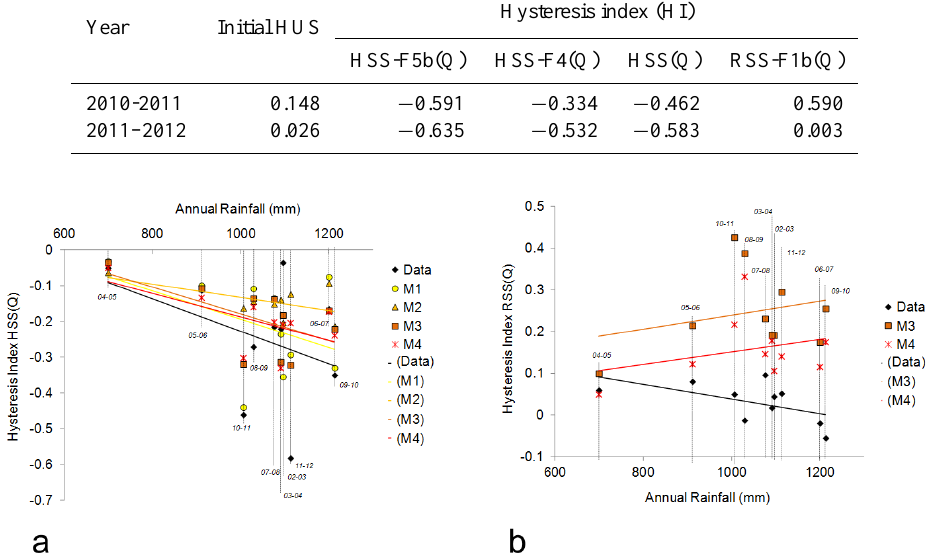
Figure 9. Variations of observed (data) and simulated (M1 to M4) hysteresis index versus annual rainfall for the 10 monitored water years for (a) hillslope saturated storage versus discharge HSS(Q) and (b) riparian saturated storage vs. discharge RSS(Q). Solid lines indicate the linear